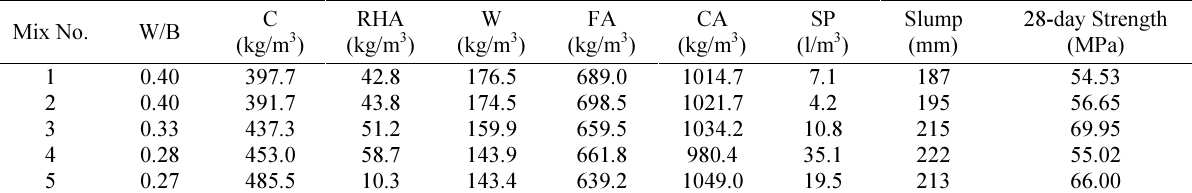
Table 7. Mix proportion, slump and strength data for validation of the models Mix No. W/B